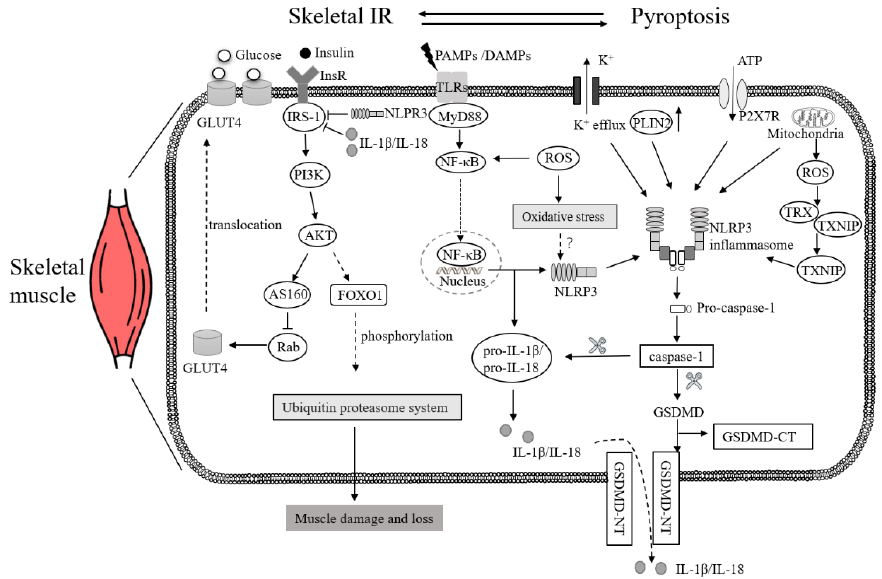
Figure 2. Possible mechanisms of skeletal muscle pyroptosis. GLUT4 is glucose transporter type4. InsR is insulin receptor. IRS-1 is insulin receptor substrate-1. AS160 (is Akt substrate of 160 kDa. FOXO1 is Forkhead Box O1. ROS stands for Reactive Oxygen Species. PAMPs stands for pathogen- associated molecular patterns. DAMPs stand for damage-associated molecular patterns. TLRs stands for Toll-Like Receptors. MyD88 is myeloid differentiation factor 88. NF- κ B is nuclear factor-kappa B. NLRP3 is NOD-like receptor pyrin domain-containing protein 3. Caspase is cysteinyl aspartate-specific proteinase. PLIN2 is Perilipin 2. P2X7R is P2X7 receptor. TRX is thioredoxin. TXNIP is TRX-interacting protein. GSDMD is Gasdermin D. IL-1 β is interleukin-1 β . IL-18 is